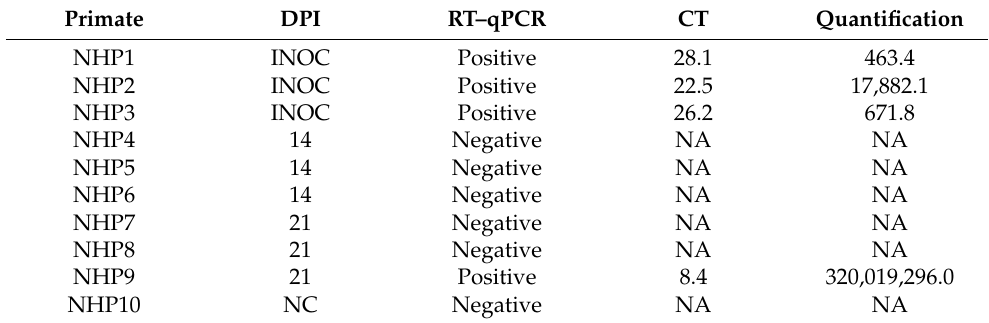
Table 2. Non-human primates of the genus Callithrix exposed to Ae. albopictus infected with YFV. Primate DPI RT–qPCR CT INOC INOC